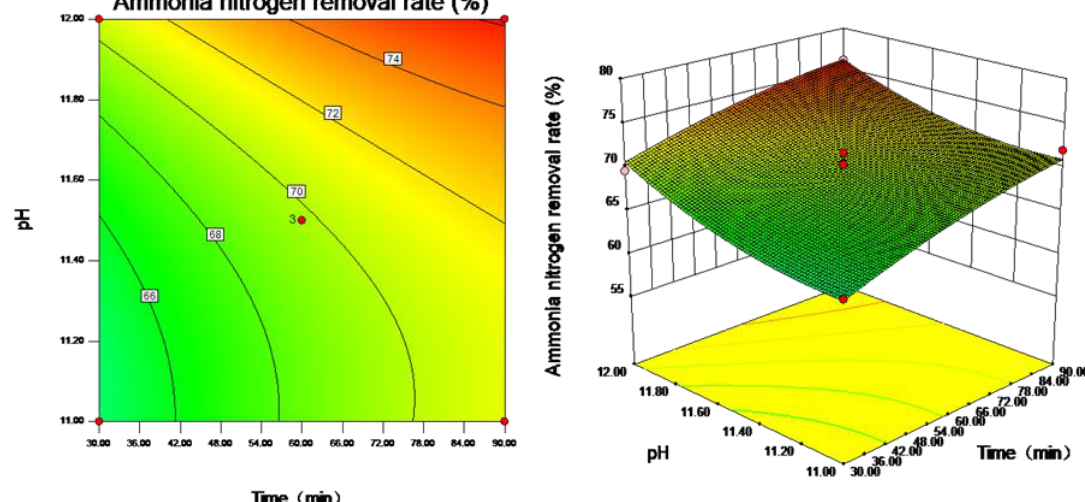
Figure 5. Contour plot and response surface plot of the effect of stripping time and pH value on ammonia nitrogen removal rate.